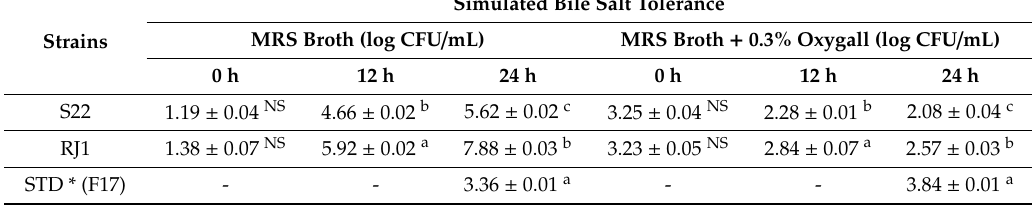
Table 2. Viable LAB counts (log CFU / mL) in simulated bile salt conditions at pH 5 for di ff erent time intervals (0, 12, and 24 h). Data represent mean ± SD ( n = 3), and values within the same column with di ff erent superscript letters (a, b, c) are significantly di ff erent at p < 0.05. STD: standard LAB, NS: not significant at p < 0.05. (* Ref